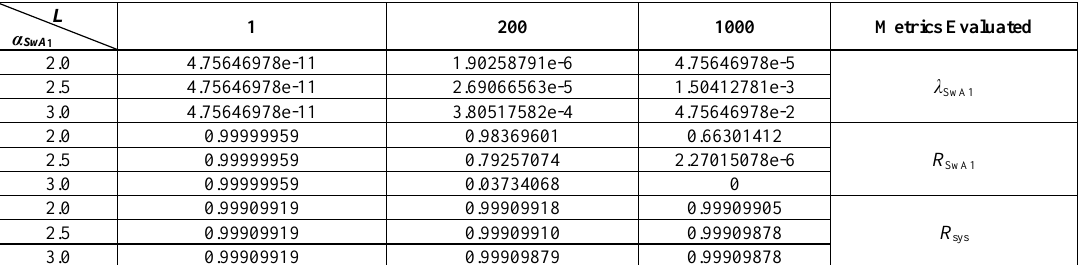
Table 8. Switch failure rate ( λ SwA1 ) and reliability ( R SwA1 ), and SAN reliability ( R sys ) at t= 8640h.